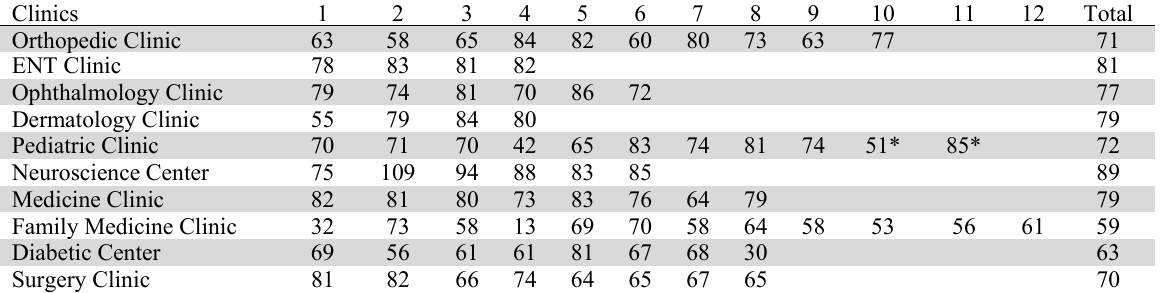
Percentages of nurse's productivity for both months (January and February 2018)